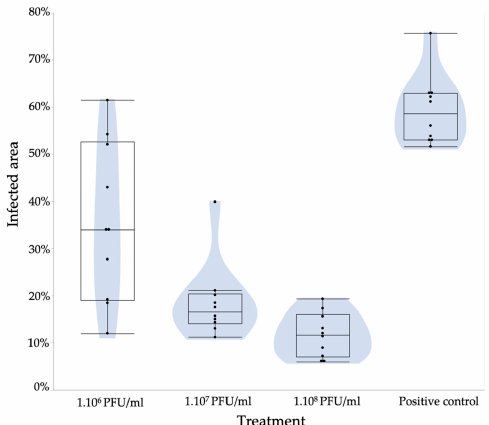
Figure 5. Reduction in E. amylovora symptoms by phage treatments on immature pear slices. Pear slices (10 slices/treatment) were treated with four phages (PEar1, PEar2, PEar4 and PEar6) with different phage concentrations (10 6 , 10 7 and 10 8 PFU/mL) and inoculated with 10 6 CFU/mL of the E. amylovora Ea1 strain. The pear slices were soaked in the mixture of phages and inoculated with Erwinia after drying. This graph shows for every treatment a box/violin plot of the infection surface. At 10 7 /10 8 and 10 6 PFU/mL, the reduction is significant, with a p -value of 0.002 and 0.0036, respectively.